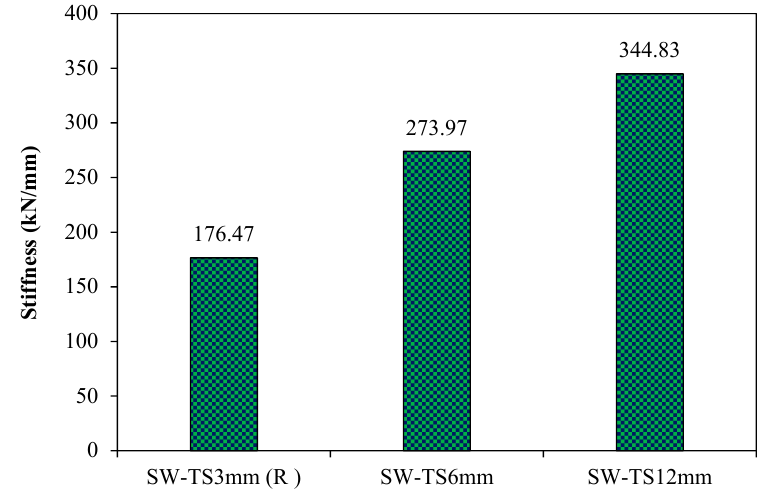
Figure 16. Stiffness of group 2 (thickness of infill steel plate).